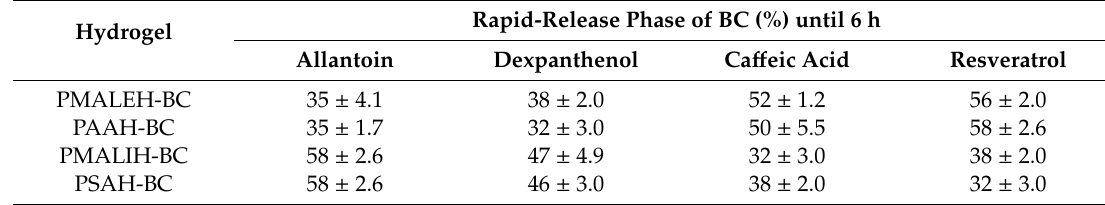
Figure 3. Release of BC from supramolecular PDCAH-BC in PBS at 33.5 °C; mean ± SEM, n = 3. Table 3. The percentage of release rate during the rapid-release phase.